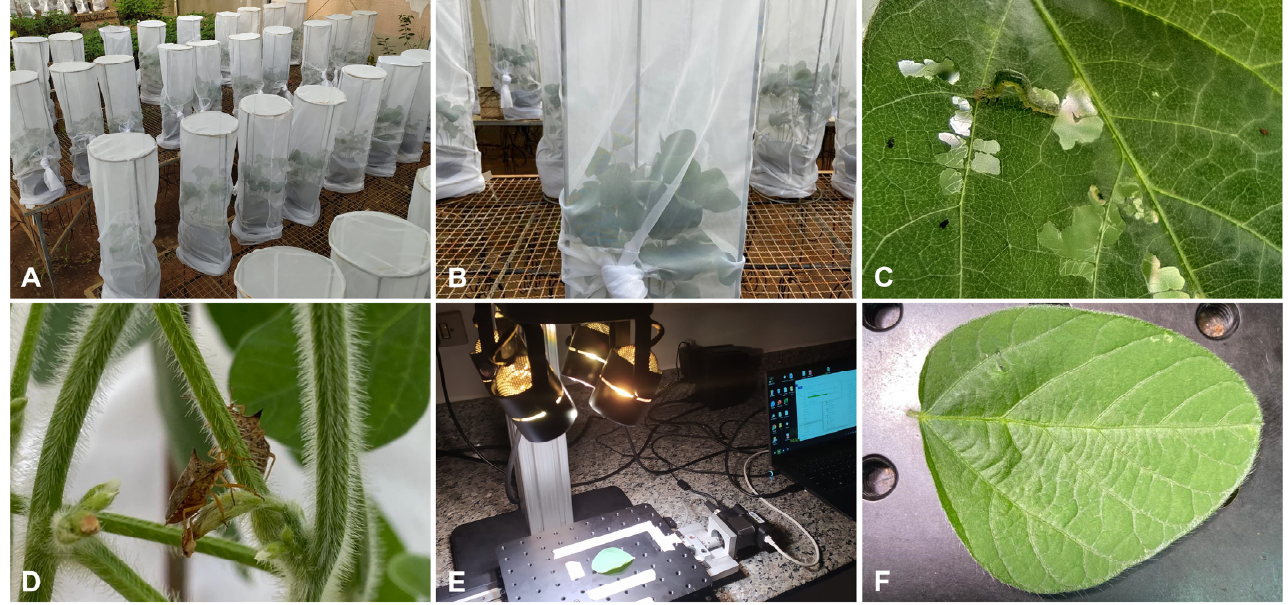
Figure 1. Overview of the experiments: ( A ) cages suitable for infestation; ( B ) close view of each pot with five soybean plants; ( C ) close view of the assay with caterpillars and injury in soybean leaf; ( D ) close view of the assay with stinkbugs; ( E ) overview of the hyperspectral data collection system; ( F ) close view of each analyzed soybean leaflet, from which hyperspectral data were collected.